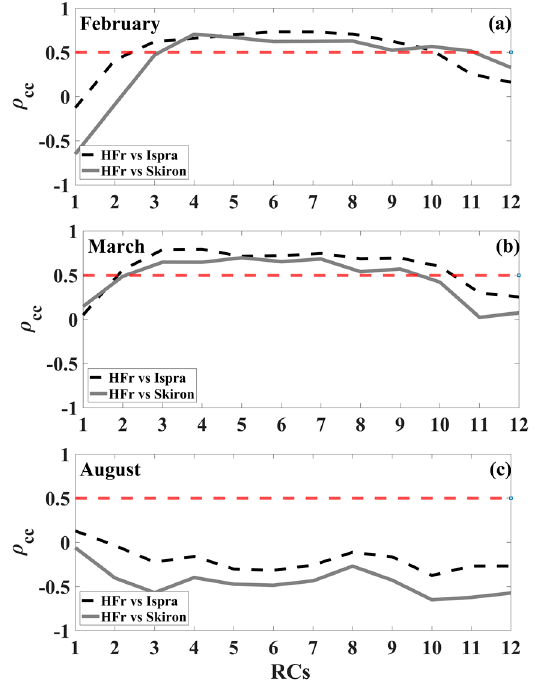
Figure 7. ρ cc relative to the comparison between HFr and ISPRA data (black dot-and-dashed line) and between HFr and SKIRON/Eta data (grey solid line) for the different RCs shown for the first winter event occurred during 6–8 February 2009 ( a ), the second winter event during 3–6 March 2009 ( b ) and the summer event 4–6 August 2009 ( c ). The red dashed lines correspond to ρ cc equal to 0.5.